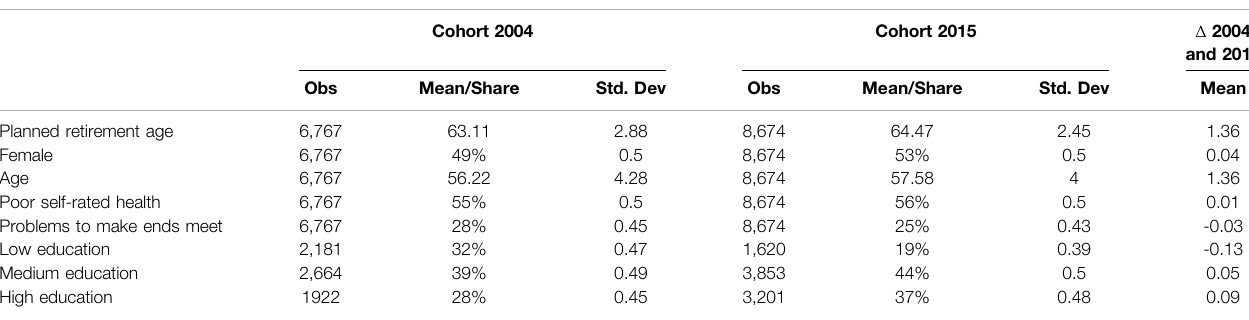
TABLE 1 | Descriptive overview of